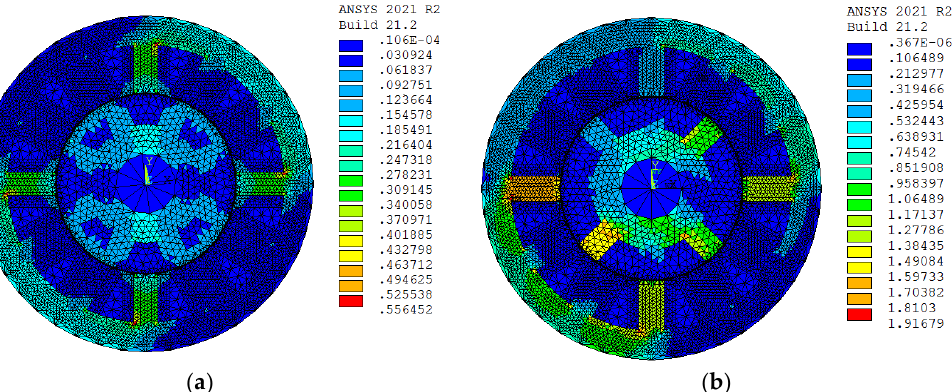
Figure 3. Flux density of the 12/8 SRM in extreme position for a current equal to 12 A: ( a ) Unaligned position; ( b ) Aligned position.